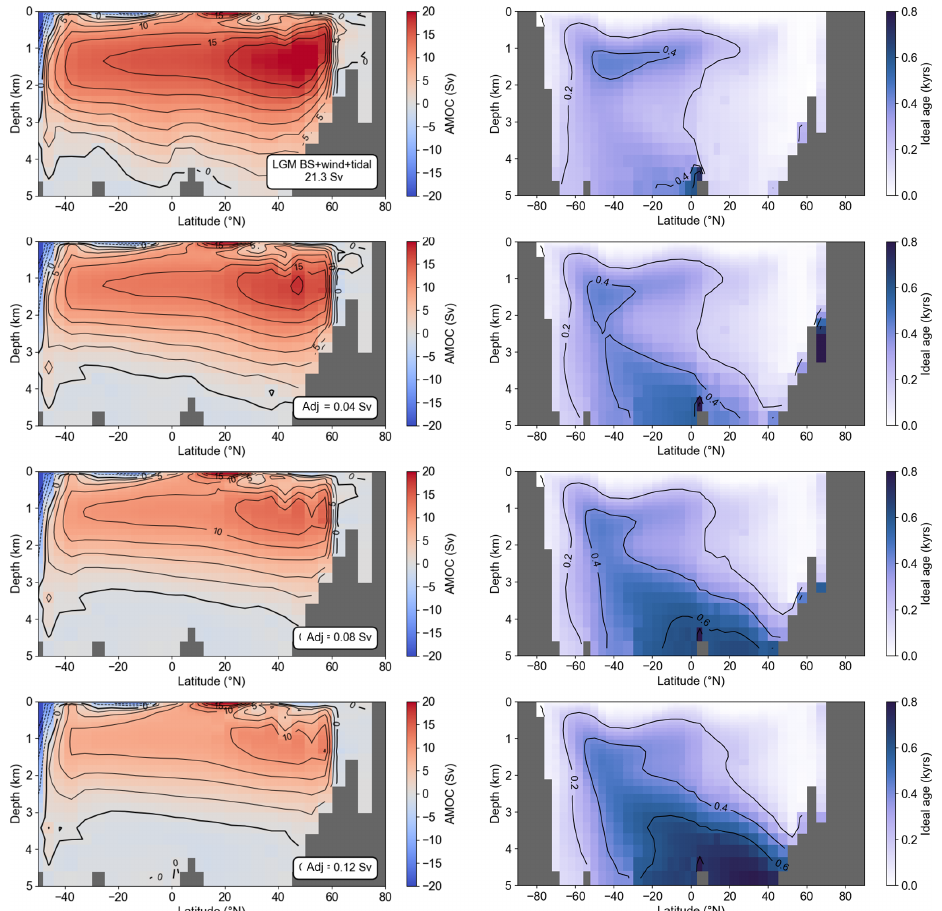
Figure B5. (Left) Zonally integrated Atlantic stream functions with all LGM forcing changes (simulation LGM_BS + wind + tidal) but freshwater adjustment of 0.04Sv to 0.12Sv between the North Pacific and North Atlantic (cf. Fig. 6). The regions of the freshwater flux and the associated salt compensation are marked in Fig. B1. (Right) Zonally averaged ideal water age in the Atlantic. Ideal ages are set to zero at the surface and increase in the ocean interior at a rate of 1yryr − 1